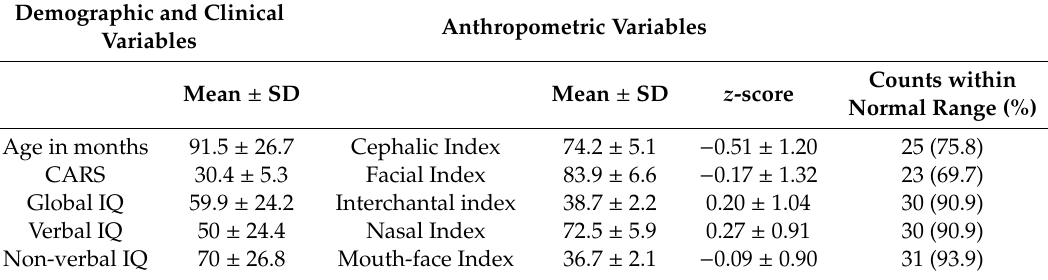
Table 2. Demographic, clinical and anthropometric characteristics of the 33 children with